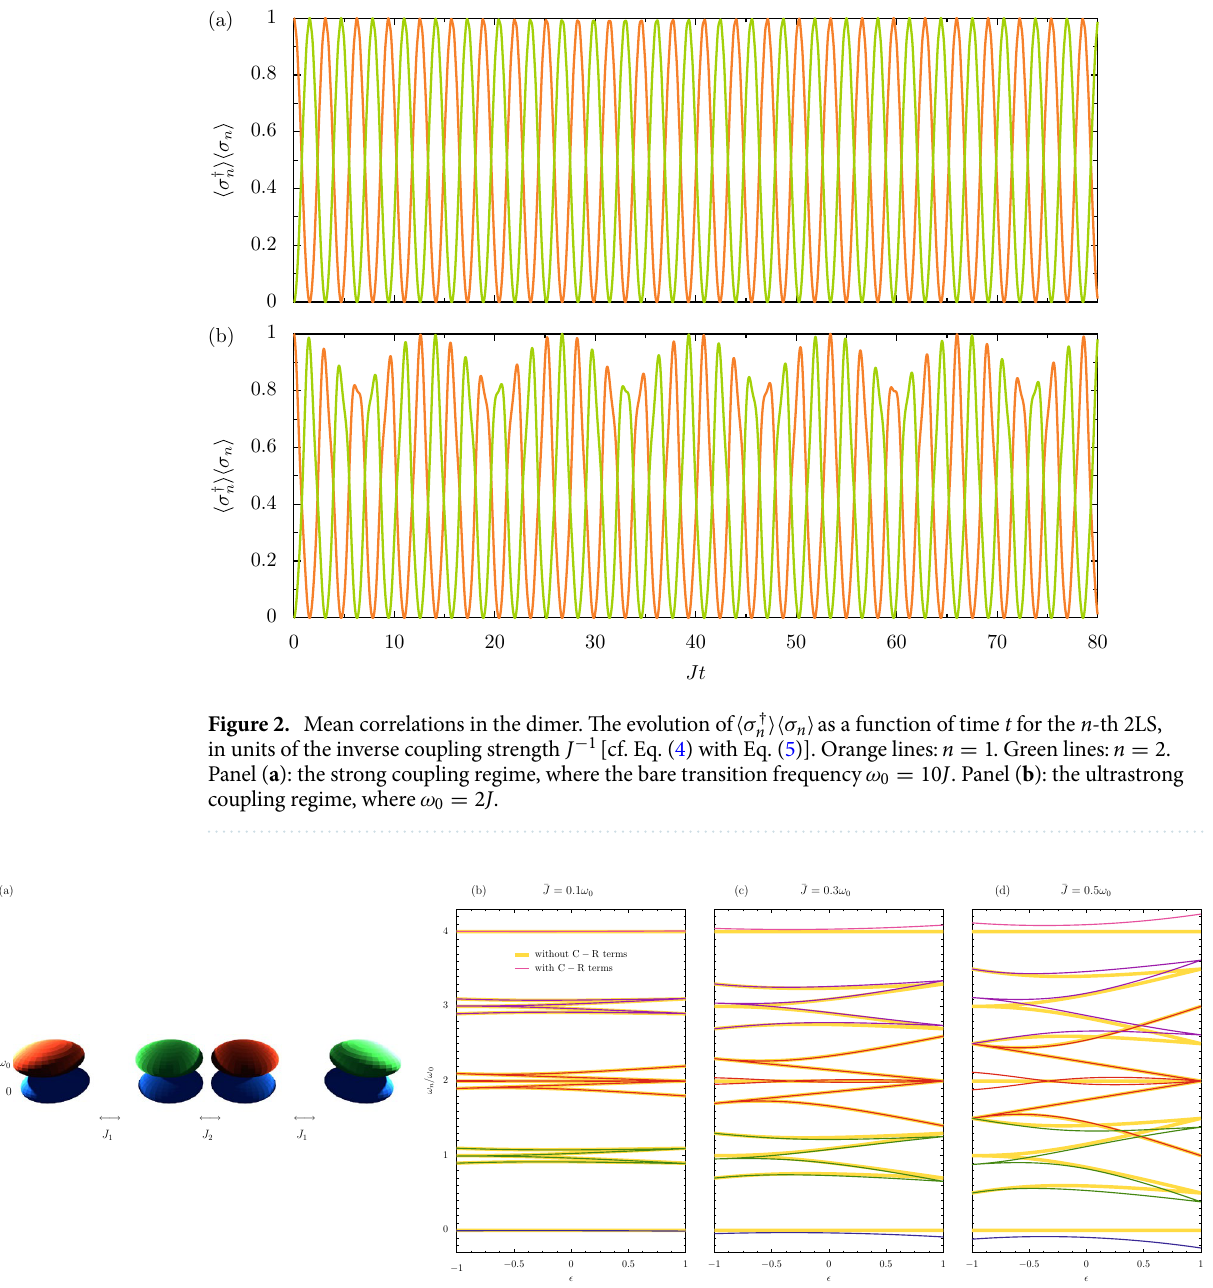
Figure 3. Ultrastrong coupling in the dimerized chain. Panel ( a ): a sketch of a bipartite array pair of two-level systems, each of bare transition frequency ω 0 , with alternating coupling strengths J 1 and J 2 along the chain of 4 [cf. Eq. (6)]. Panels ( b – d ): the eigenfrequencies as a function of the dimerization parameter ǫ , for size N = increasing coupling strength ¯ J across the panels [cf. Eq. (7)]. Thin colored lines: the eigenfrequencies ω n , found by diagonalizing the full Hamiltonian of Eq. (6). Thick yellow lines: ω ′ n , found upon neglecting the C-R